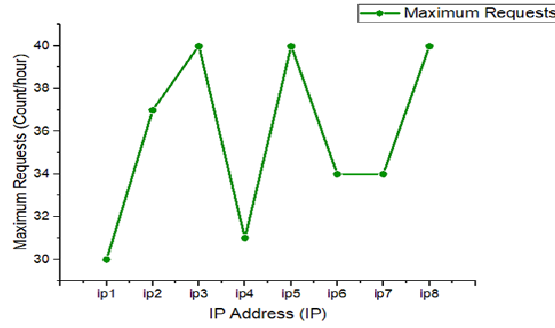
Fig 5: Request frequency from 9 AM to 5